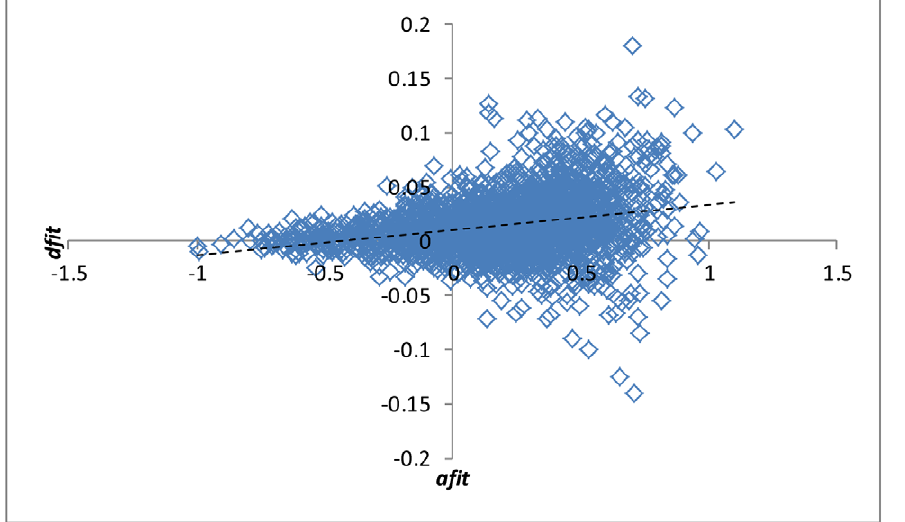
Figure 4. Relative goodness of fit for the UPM vs the MC model ( dfit ) plotted against the average goodness of fit ( afit ). dfit : log 10 ( E 2 MC,k / E 2 UPM,k ). afit : 2 (log 10 ( E 2 MC,k ) + log 10 ( E 2 UPM,k ))/2.